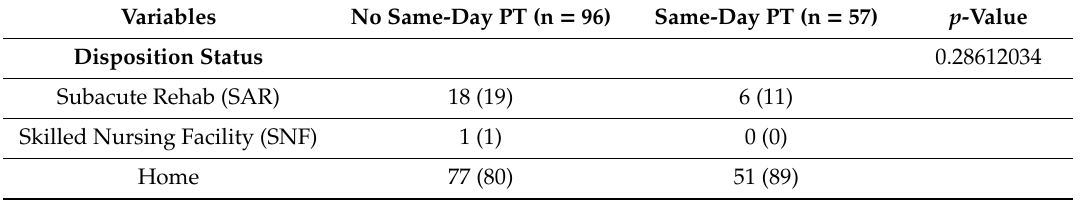
Table 4. Bivariate comparisons of disposition status by same-day PT, represented as counts